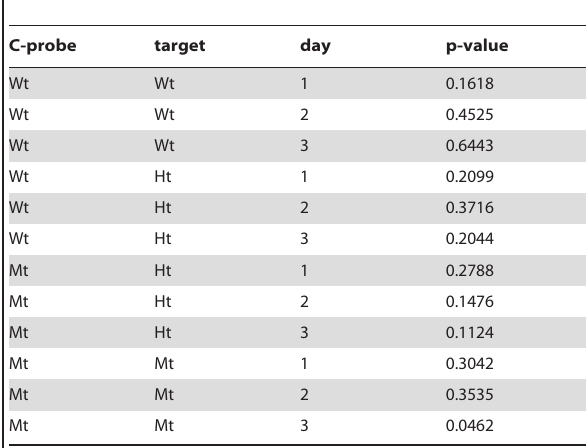
Table 3. Comparison of Rts from plates within